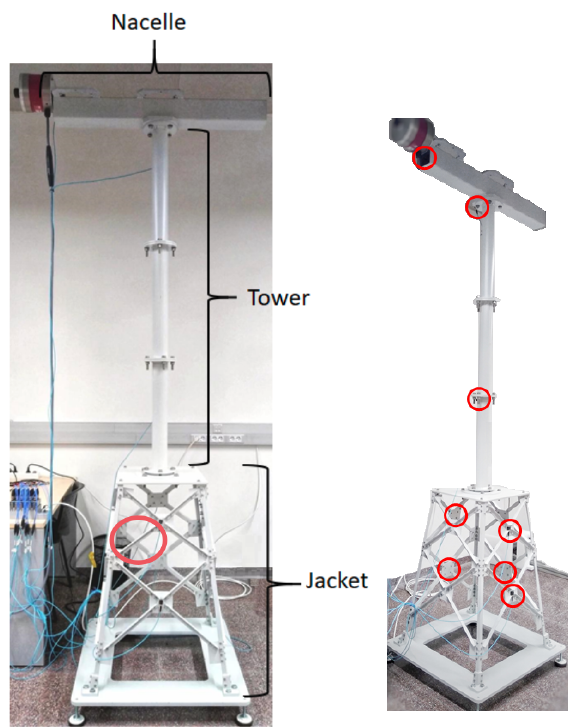
Figure 2. The experimental setup ( left ) detailing the location of the damaged bar (red circle). Location of the sensors on the overall structure ( right ).